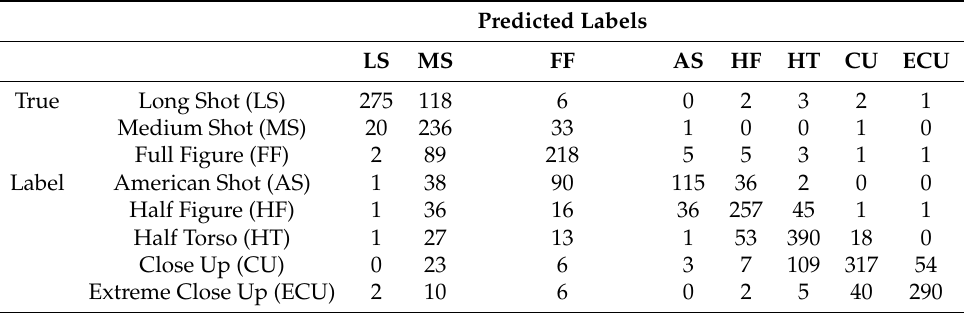
Table 14. Confusion Matrix of a Resnet-50 trained on OD plus flip on the y-axis.